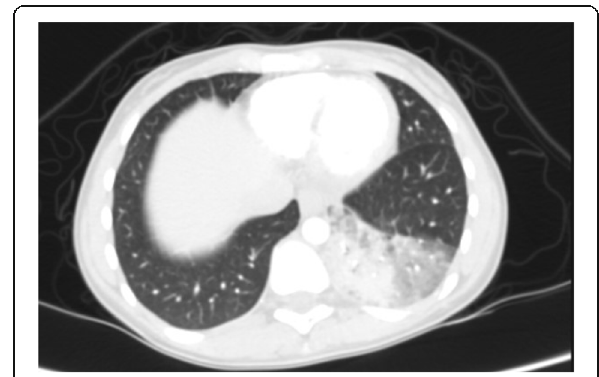
Fig. 18 Streptococcus pneumonia: thin section CT shows segmental consolidation and GGO in left lower lobe